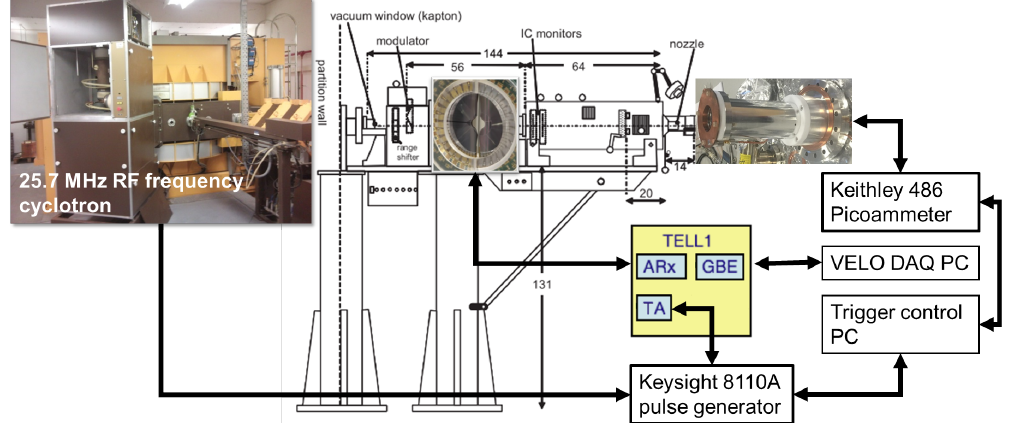
Figure 7. Synchronisation of the readout of the VELO modules and the Faraday Cup optimised for the integration at the CCC proton beamline. A master trigger regulates the output of the pulse generator synchronised to the RF frequency of the cyclotron for generating readout triggers for the VELO modules and controls the picoammeter measuring the beam current by the